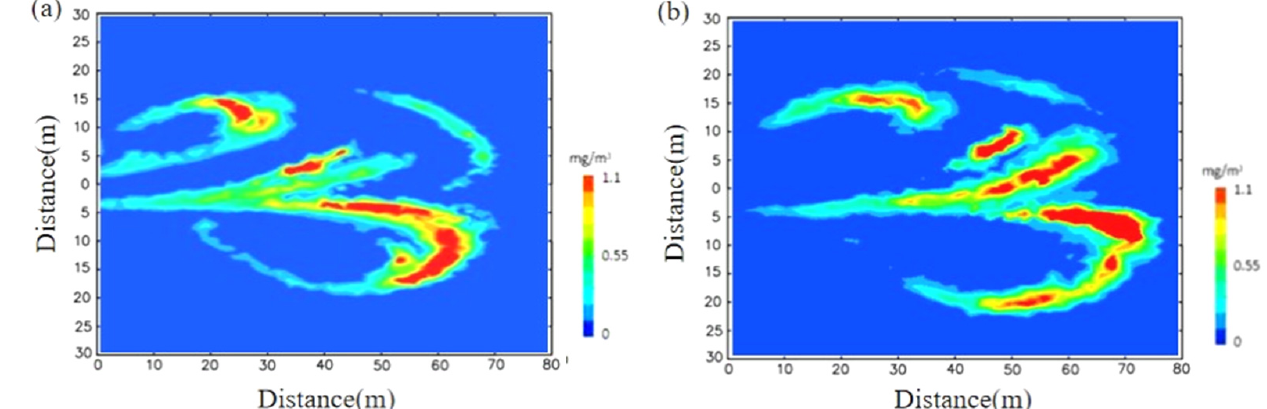
Figure 8. PM 10 concentration profiles at the horizontal direction at 1.5 m heights during daytime and nighttime by CFD technology: ( a ) daytime and ( b ) nighttime (outside).